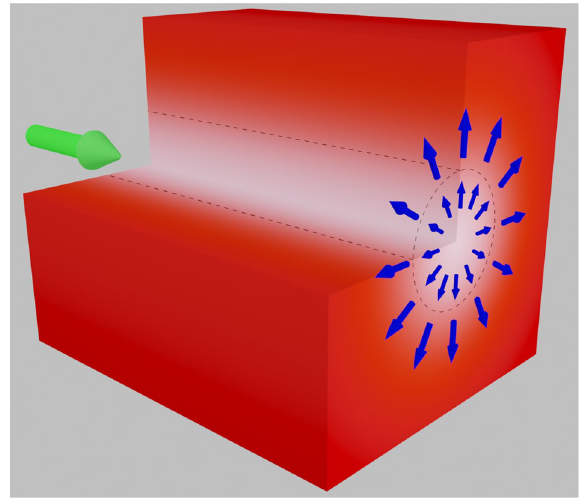
Figure 1. Transversal distribution of force exerted by a vortex beam on a generic colloidal system. The force field generates a flux of particles across the surface of a cylindrical volume oriented along the propagation direction of the